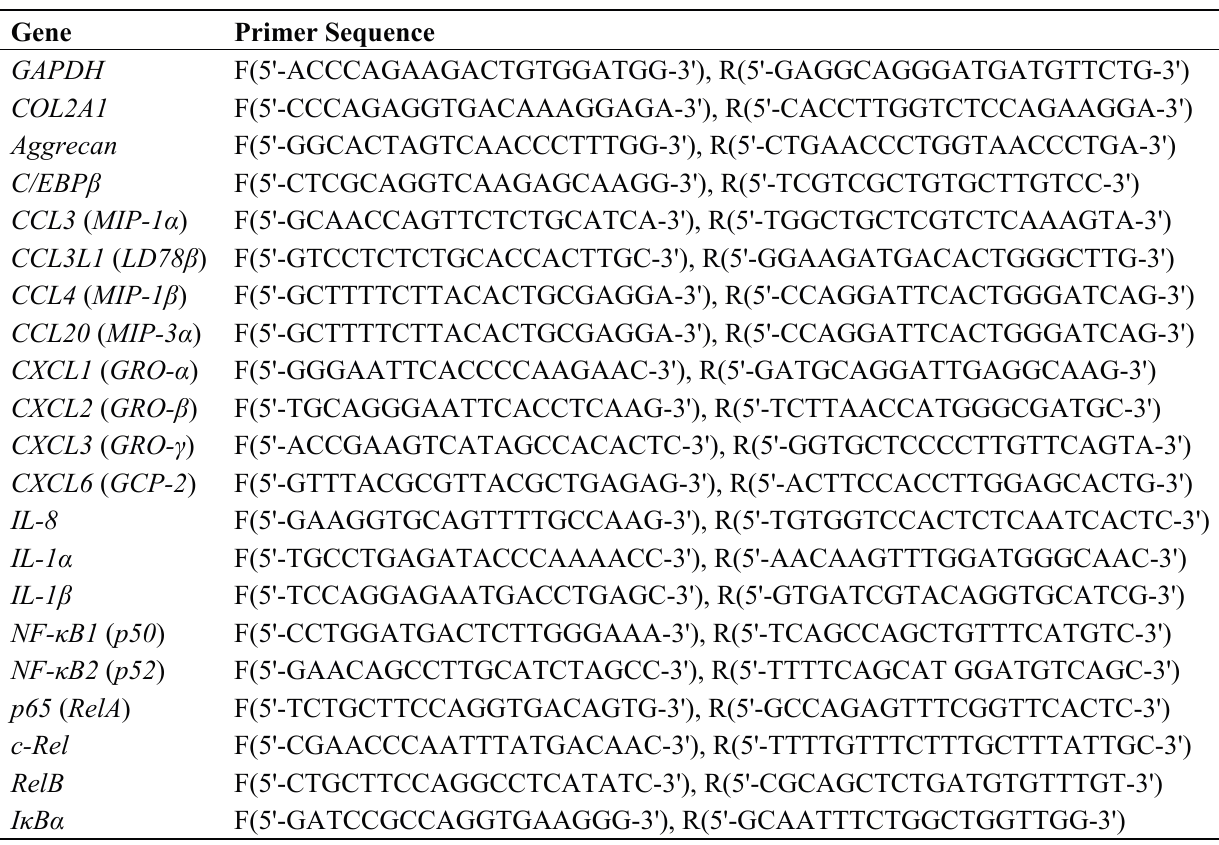
Table 1. Primers for real-time quantitative